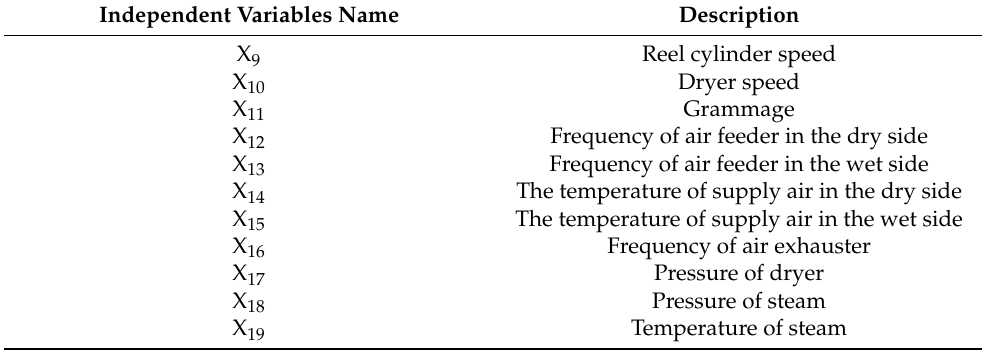
Table 2. Details of